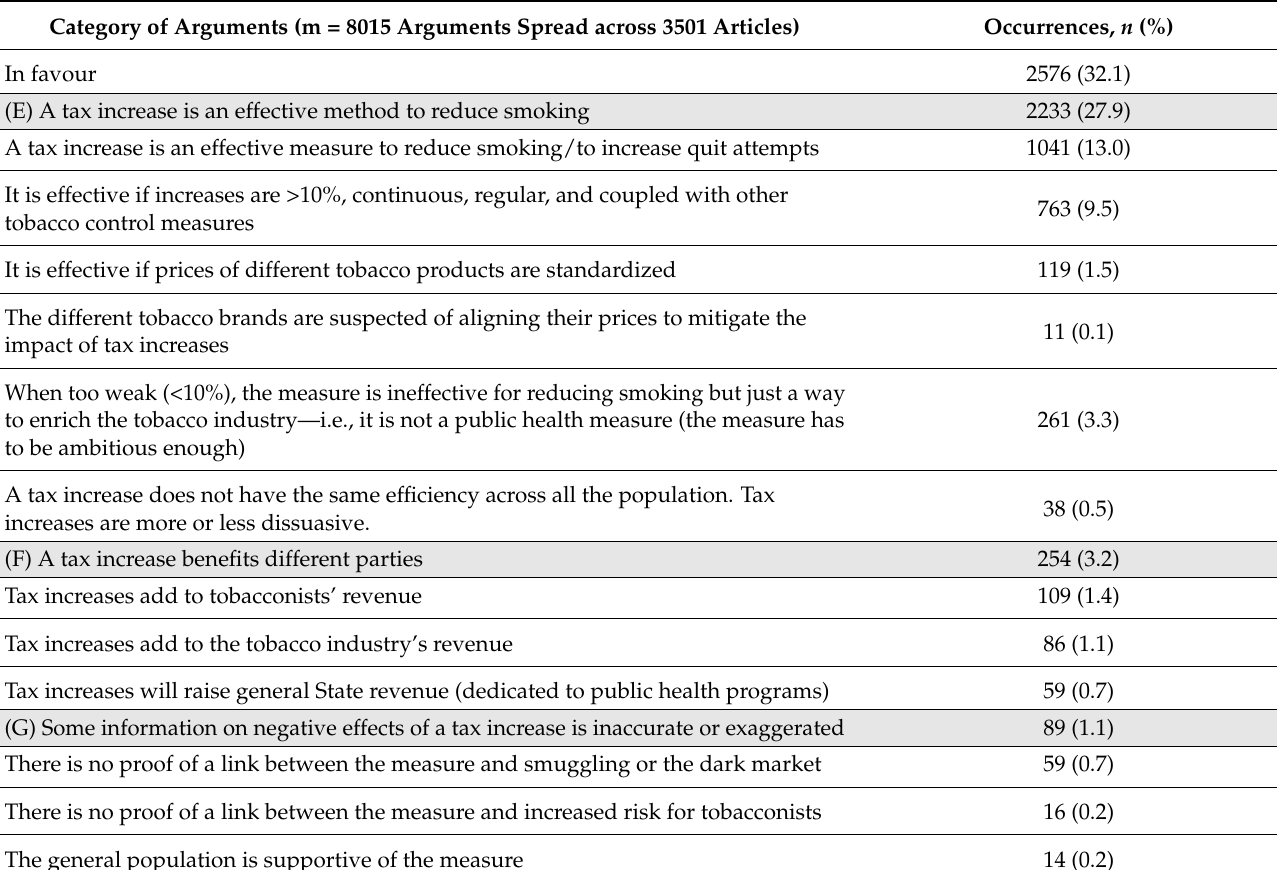
Table 3. Arguments in favour of tobacco tax